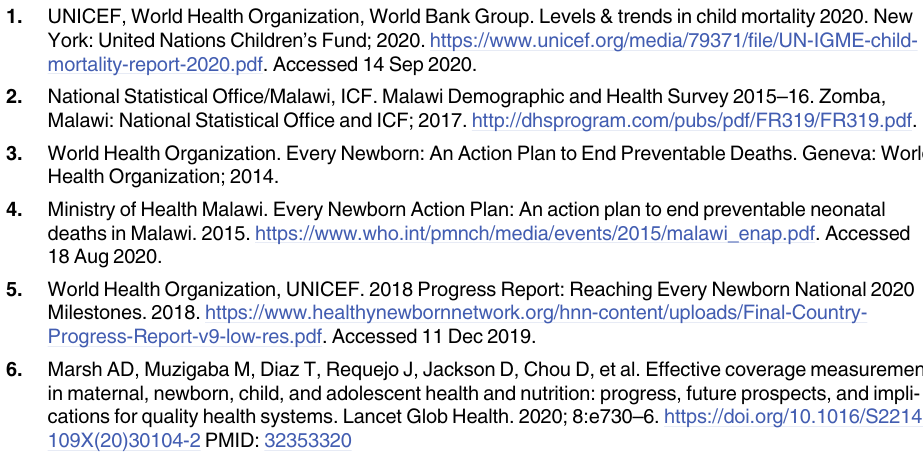
S1 Table. Service readiness score domains and indicators (adapted from Wang et al (2019)). S2 Table. Postnatal care interventions and question wording from the phase seven DHS model questionnaire. S3 Table. Co-coverage of newborn care by place of birth. S4 Table. Crude risk ratios. S5 Table. Sensitivity analysis excluding home